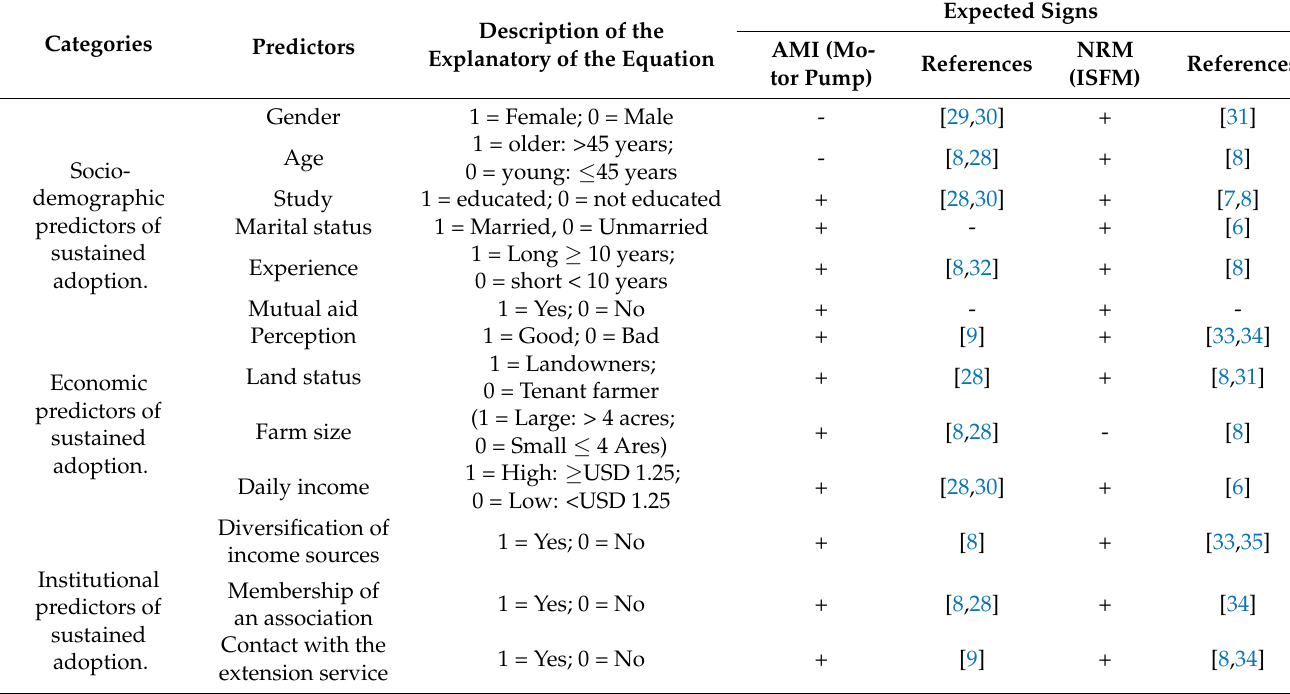
Table 1. Predictors used in binary logistic regression (Logit